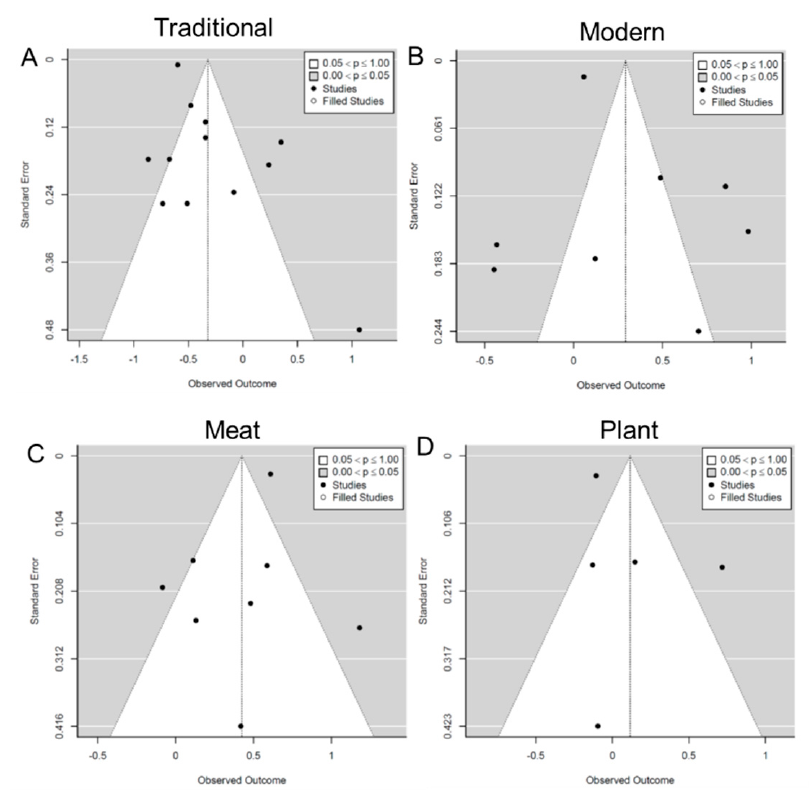
Figure 2. Funnel plot of pooled odds ratios (ORs) with 95% confidence interval (CI) for the highest versus lowest quantile of the different dietary patterns for overweight/obesity. ( A ) traditional dietary pattern; ( B ) modern dietary pattern; ( C ) meat/animal protein dietary pattern; ( D ) plant food/vegetarian dietary